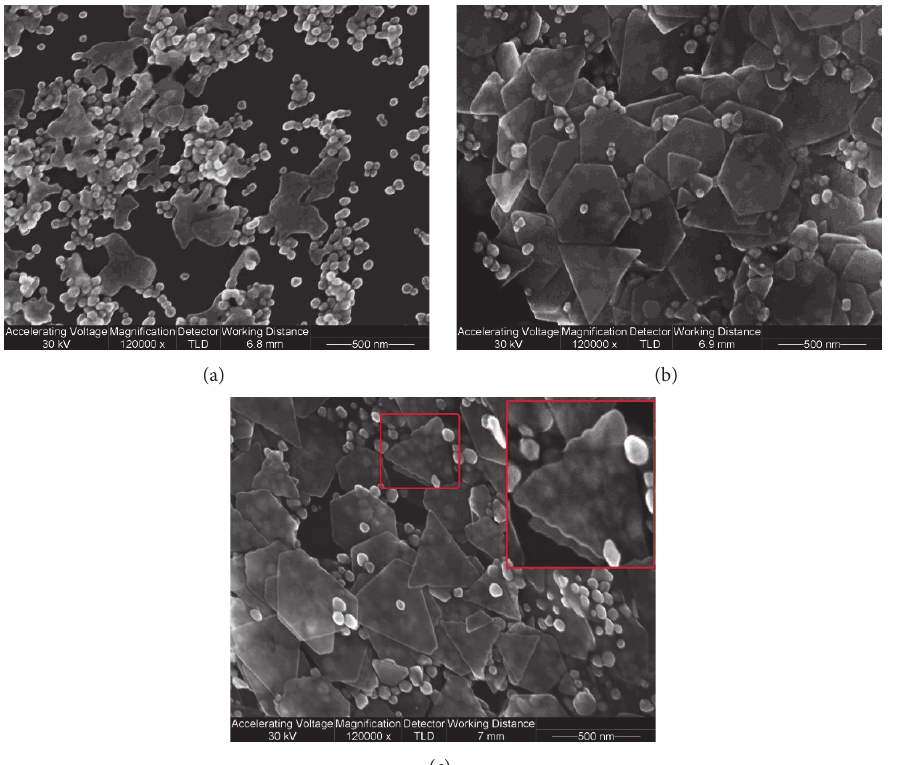
Figure 6: SEM images showing results from gold nanoparticle synthesis with variances in KBr concentrations. (a) 0.060 mM KBr, (b) 0.075 mM KBr, and (c) 0.090 mM KBr with inset of zoomed-in